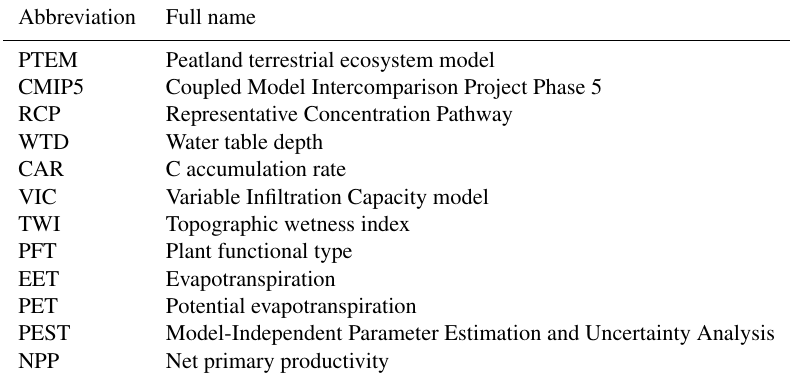
Table 1. List of